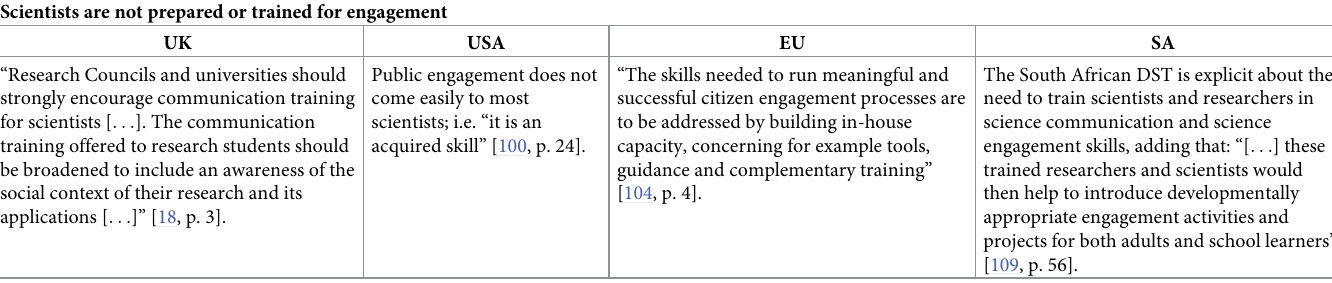
Table 10. Criticisms in policy documents: Scientists’ lack of preparedness.